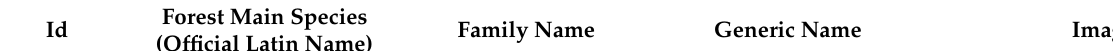
Table A1 shows images of forest main species in Table 2. Table A1. The forest main species and their corresponding images. Table A1. The forest main species and their corresponding